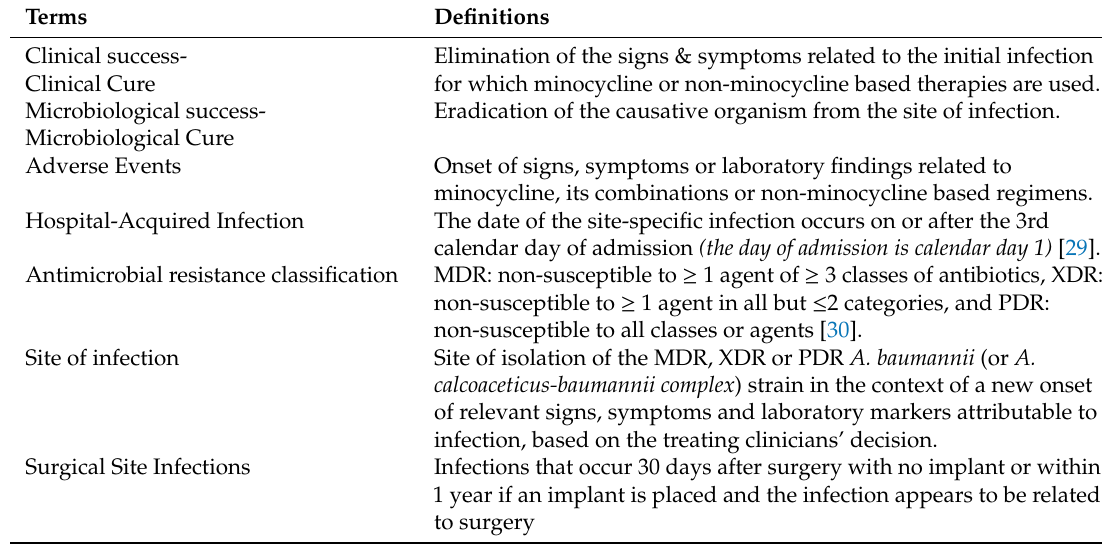
Table 1. Definitions used in the systematic